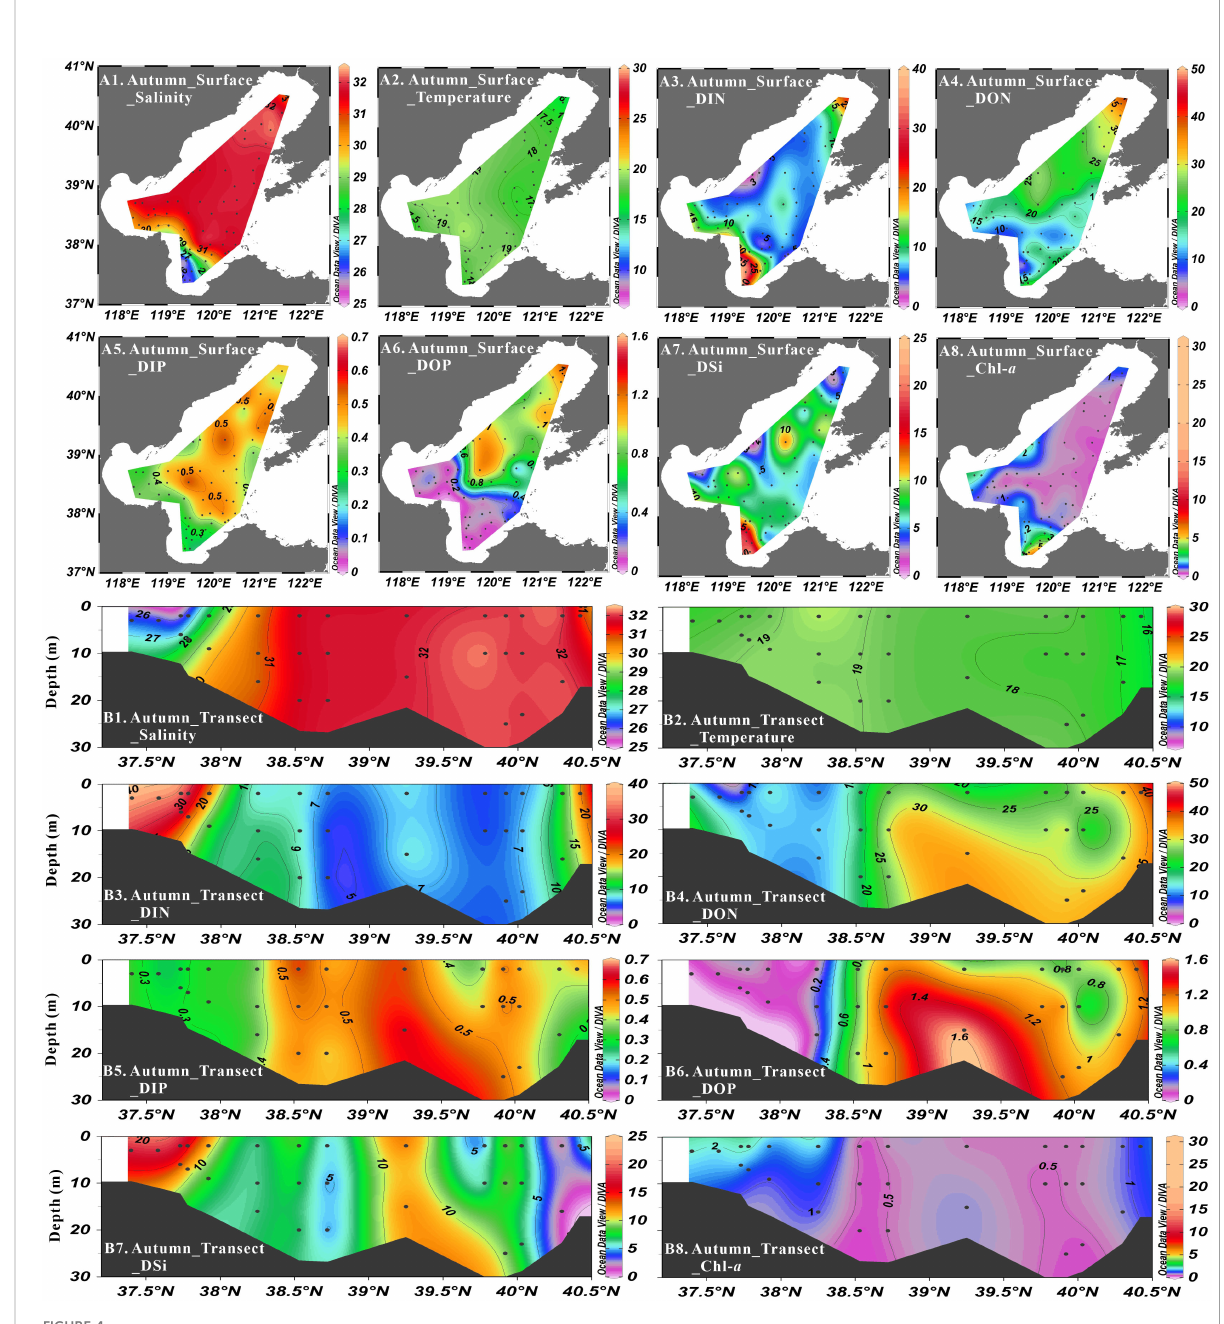
FIGURE 4 Distribution of salinity (psu), temperature (°C), DIN concentration ( m mol·L -1 ), DON concentration ( m mol·L -1 ), DIP concentration ( m mol·L -1 ), DOP concentration ( m mol·L -1 ), DSi concentration ( m mol·L -1 ) and Chl- a concentration ( m g·L -1 ) at surface layer (A1-A8) and Northeast-Southwest transect (B1-B8) in